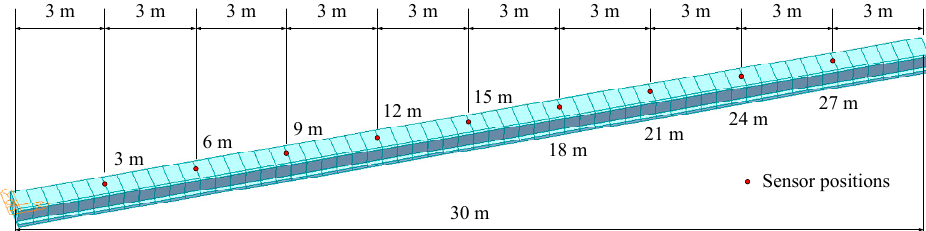
Figure 3. Finite element model of a simply supported bridge.